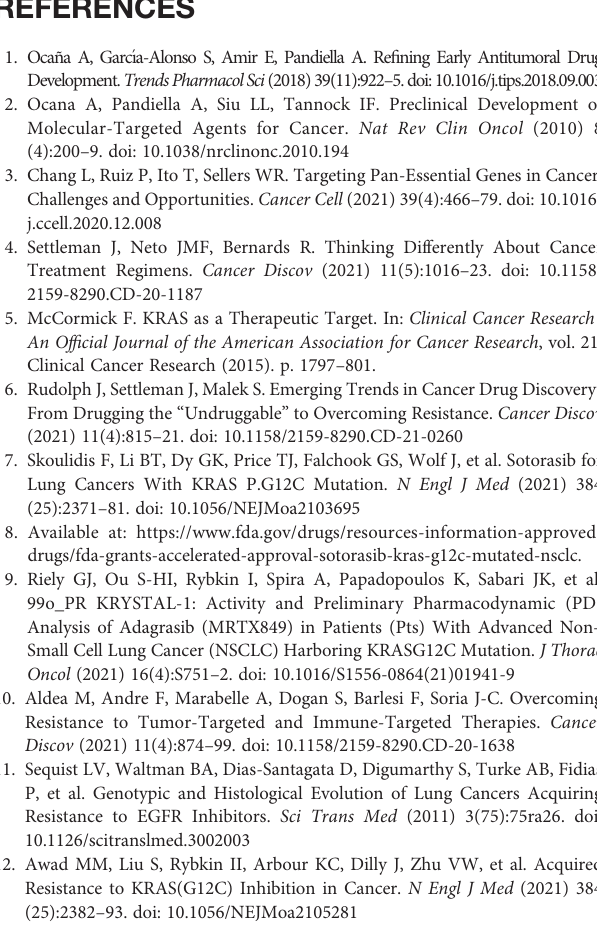
expression is signi fi cantly higher in tumor samples than in normal tissue (D). No correlation between CLDN10 and TMPRSS6 geneexpression withmostof immune in fi ltrates. Supplementary Figure 5 | Higher expression of CLDN10 and TMPRSS6 in K-RAS p.G12C. (A) Table presenting 15 NSLC cell lines that present the G12C variant in K-RAS gene. Bar graph showing the expression of CLDN1 0 in (B) , and TMPRSS6 in (C) in 92 NSLC cell lines compared to those 15 selected in A. Expression of CLDN1 0 in (D) , and TMPRSS6 in (E) in LUAD tumor samples comparing those that harbor or not the G12C mutation. Supplementary Table 1 | Investigational and approved drugs against K-RAS identi fi ed mutations. Speci fi c K-RAS mutation, name of the drug, status (approved or investigational), identi fi cation code (NCT) and clinical studies with links and phases are included. Intervention is included if the drug is given in combination with others. Supplementary Table 2 | Gene functions of thirteen selected deregulated genes. Supplementary Table 3 | Upregulation details of cell surface-related genes analyzed. Name of the gene, mean of expression in mutant and wildtype K-RAS tumors, fold change (FC), direction and p-value are included. Supplementary Table 4 | Kaplan-Meier survival values of cell surface-related genes.Tableincludesthenameofthegene,thehazardratio(HR)(inblue,signi fi cant good prognosis, and in red, bad one), p-value and fold discovery rate (FDR) for FP and in LUAD